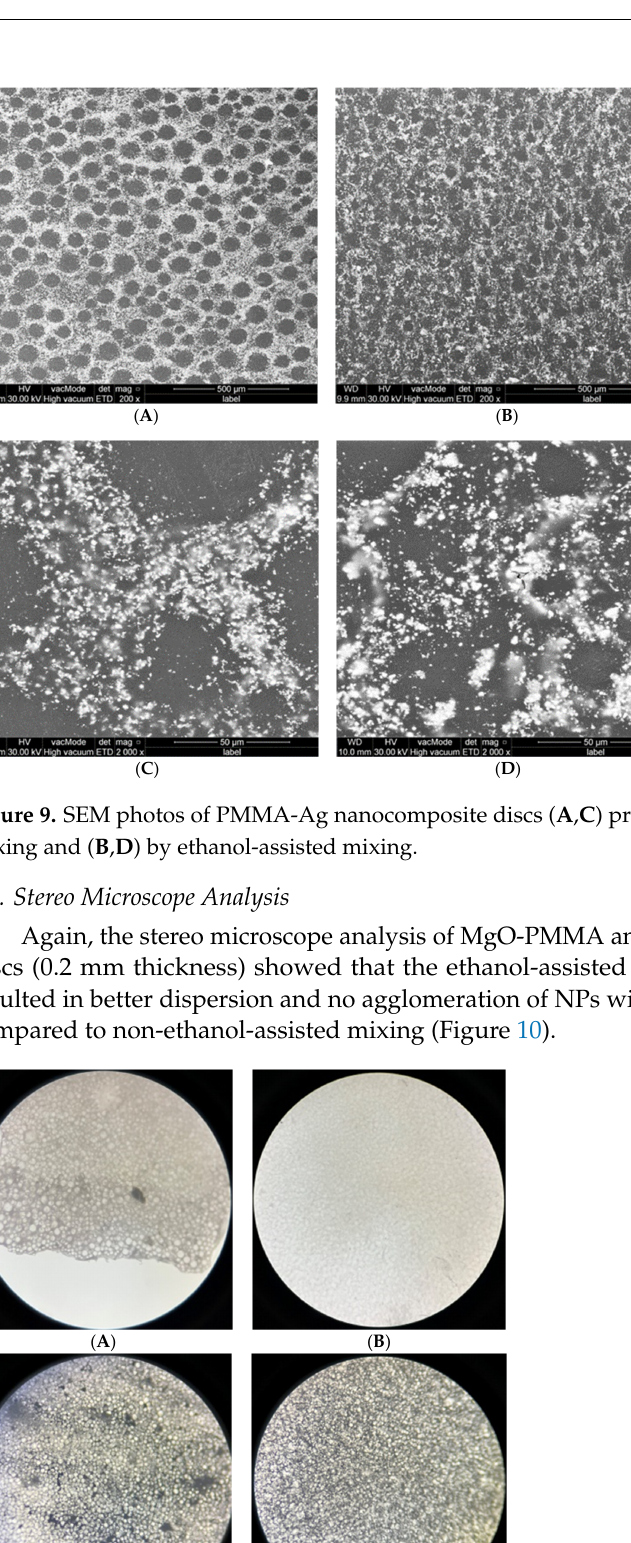
Figure 10. Stereo microscope photos of PMMA-MgO nanocomposite disc (( A ) non-ethanol-assisted and ( B ) ethanol-assisted) and PMMA-Ag nanocomposite disc (( C ) non-ethanol-assisted and ( D ) ethanol-assisted).